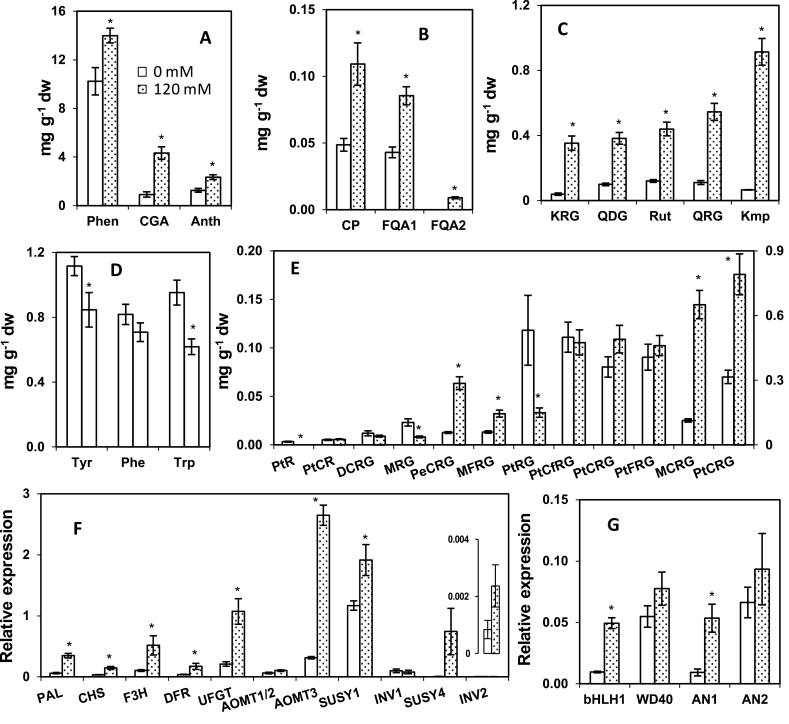
Metabolite and gene expression changes associated with sucrose feeding. (A–E) Amounts of total phenolics, total chlorogenic acids (5CGA plus isomers), and total anthocyanins (A), caffeoyl and feruloyl derivatives (B), individual flavonols (C), aromatic amino acids (D), and anthocyanins (E). PtCRG is shown on the right y-axis, and all others on the left. (F, G) Expression of phenylpropanoid and sugar-related genes, with expression of INV2 shown in the inset (F), and transcription factors in potato plantlets (G) cultured on 0mM (open bars) and 120mM (dotted bars) sucrose. Data represents the means±SEM of three biological replicates. Asterisks indicate treatments that are significantly different (P<0.05).